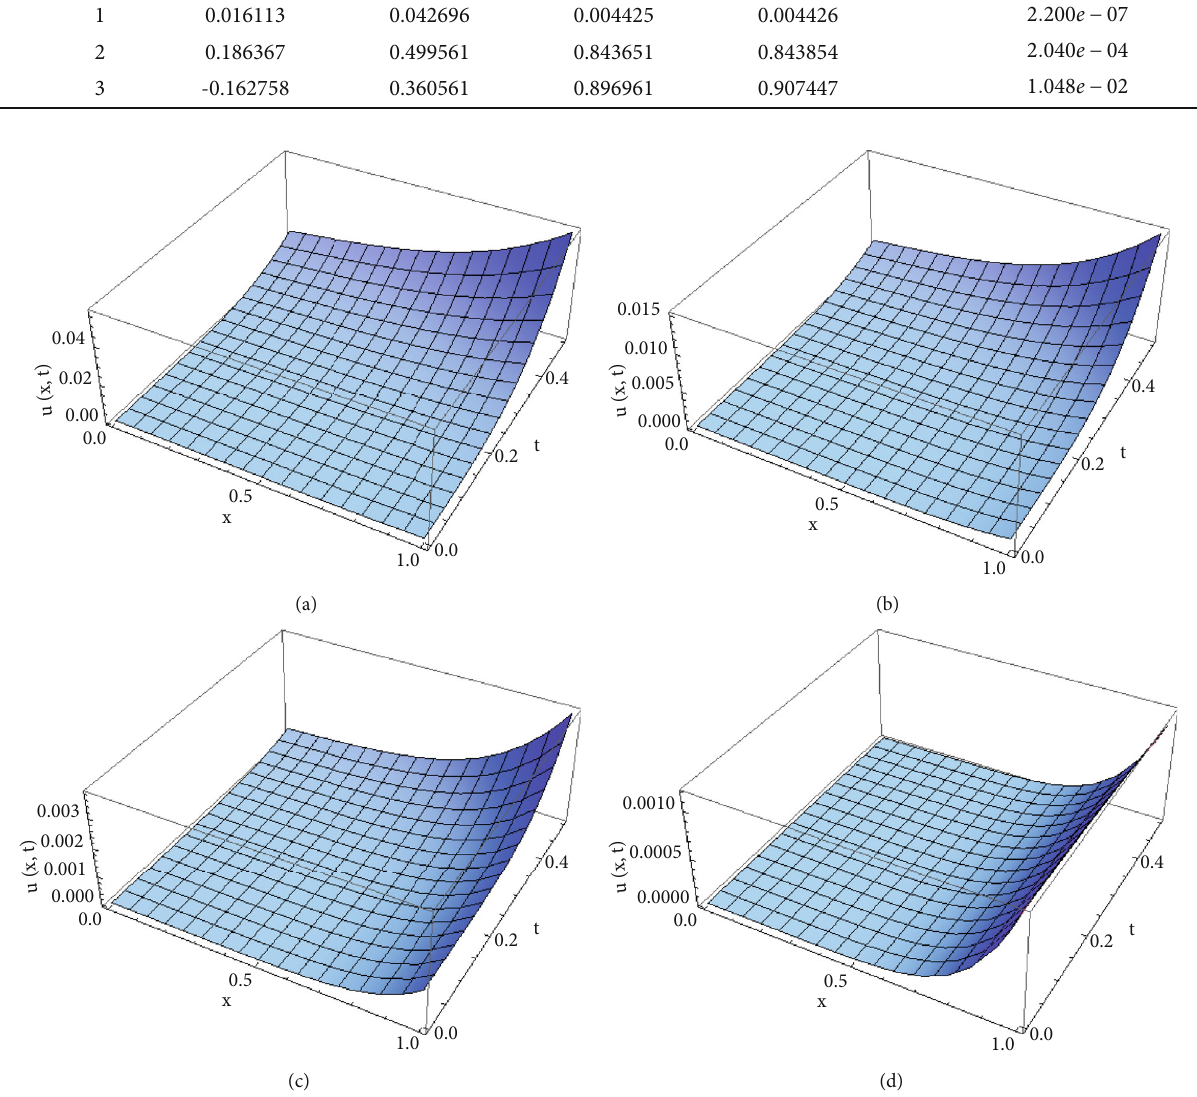
Figure 3: The physical behavior of FRDTM solution of Eq. (28) for (a) α = 0 : 25 , (b) α = 0 : 5 , (c) α = 0 : 75 , and (d) α = 1 .